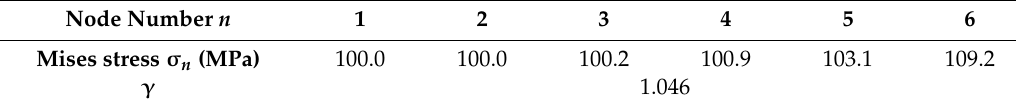
Table 5. The Mises stress of each node and the γ for specimen A 1 B 1 C 1 D 1 E 1 .